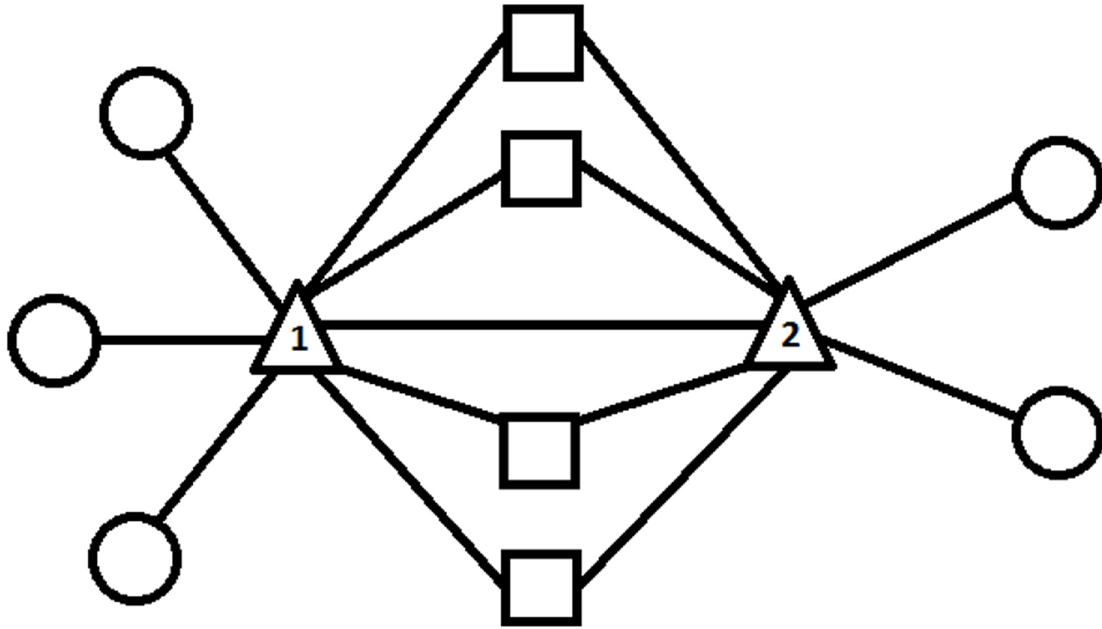
Fig 1. Example of a MNS calculation. Node 1 shares 4 neighbouring nodes (squares) with node 2. Since this is an undirected network, the MNS of node 1 to node 2 is 4, and vice